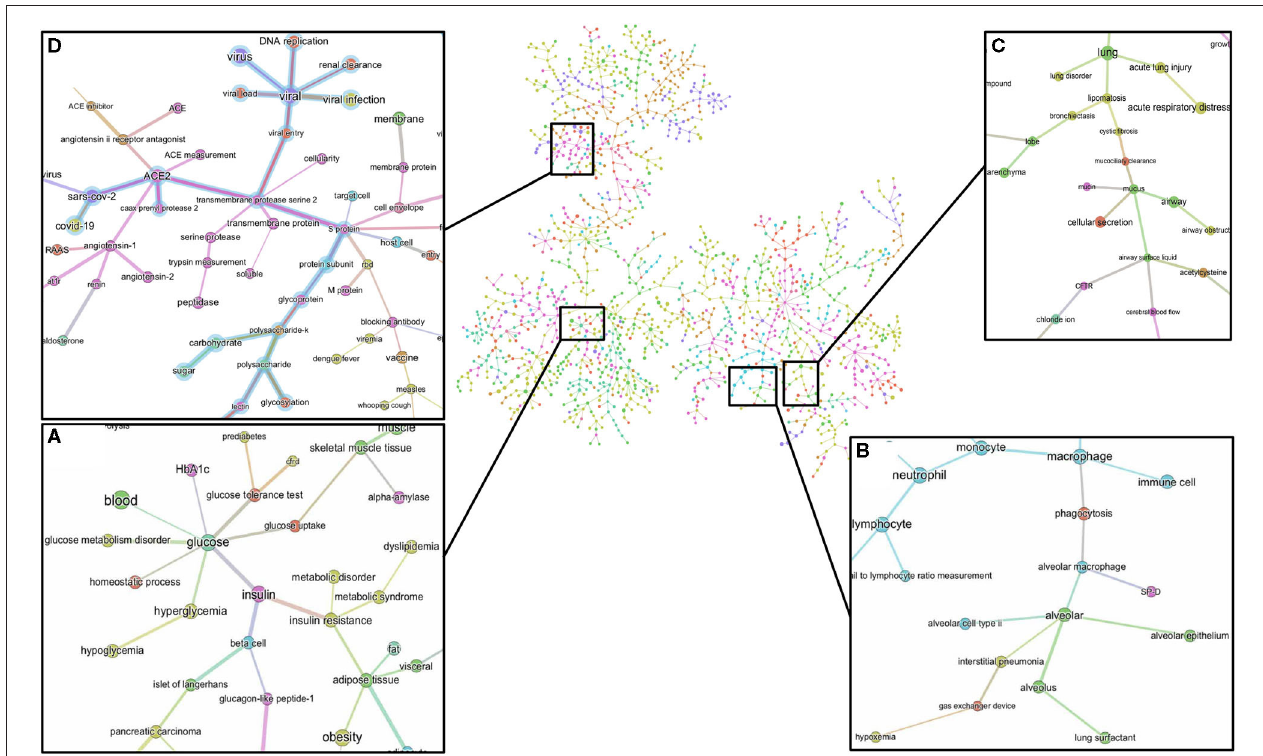
FIGURE 7 | Minimum spanning-tree and zoom-in. Minimum spanning-tree is constructed from the 1,500 most frequent entities extracted from the 3,000 most relevant articles in the CORD-19 database, according to the query “Glucose as a risk factor for COVID-19” (see also Supplementary Figure 4 ). Selected zoom-in for “glucose” (A) , “alveolus” (B) , “lung” (C) and “viral entry” (D) are shown as exemplar of deep analysis of the tree. A high-resolution pdf version of the spanning-tree is available ( Supplementary Figure 4 high